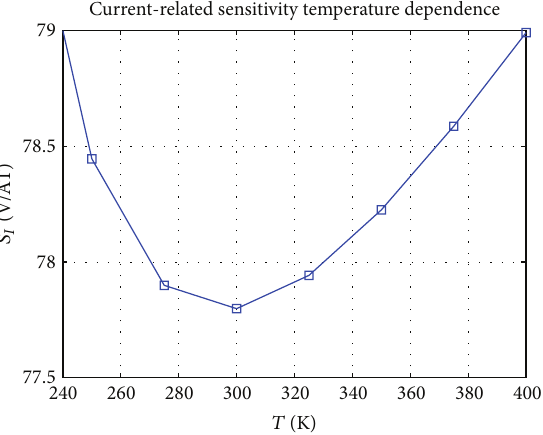
Figure 12: The simulated current-related sensitivity 𝑆 𝐼 versus the